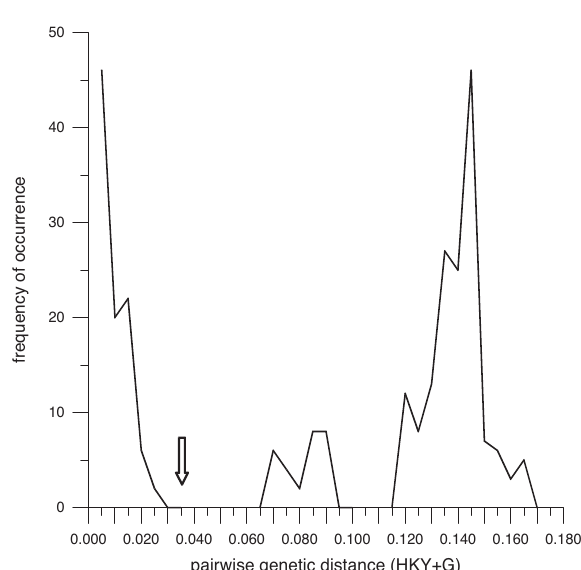
Fig. 2. – Maximum-likelihood estimates of pairwise genetic dis- tances corrected for multiple hits, the mode choice is based on a likelihood-ratio test (for details see text). The arrow marks the smallest interspecific distance in the homologous region of the mitochondrial LSU (16S) gene between the species of marine isopods in Held (2003).